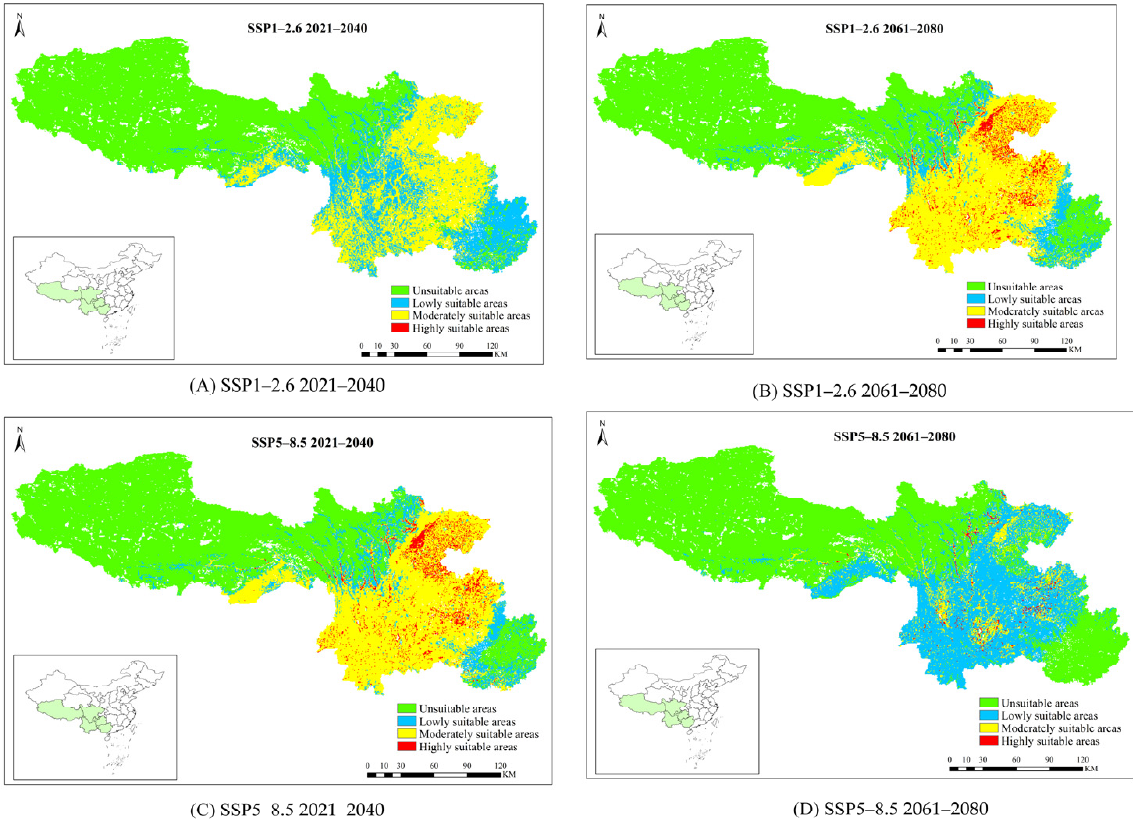
Figure 6. The future potential distribution of P. yunnanensis under different climate scenarios. Under the SSP1-2.6 climate scenario, the area of lowly suitable areas for P. yunnanensis from 2021 to 2040 is expected to increase in southeastern Tibet, western Yunnan and